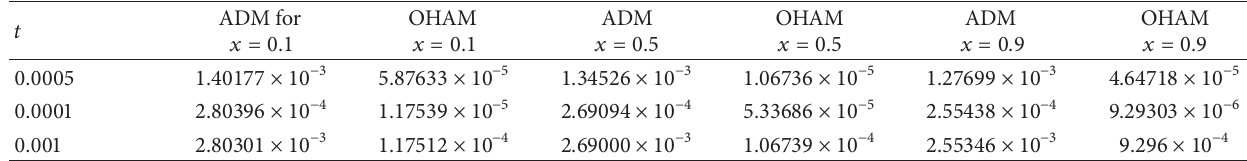
Table 6: Comparison of absolute errors obtained by OHAM and ADM [5] for 𝛼 = 1 , 𝛽 = 1 , and 𝛿 = 2 .